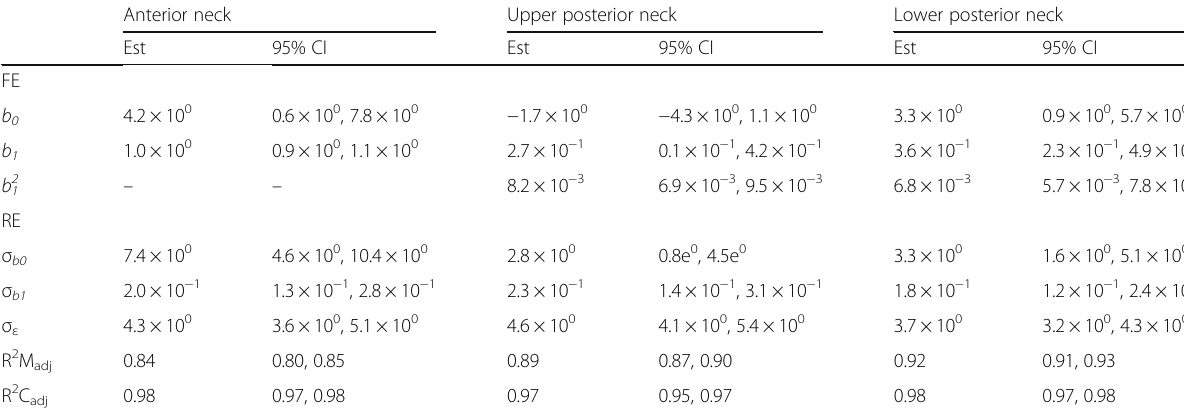
Table 1 Final EMG-force relationship models Anterior neck Upper posterior neck Lower posterior